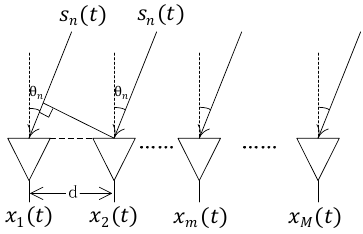
Figure 1. The geometry of ULA with M antennas.